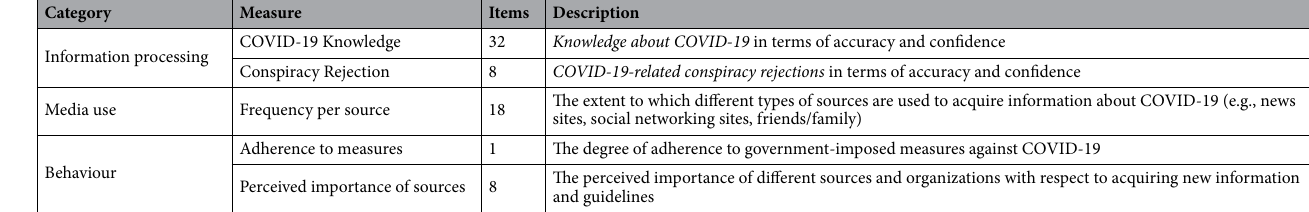
Table 6. Overview and descriptions of the measures in wave